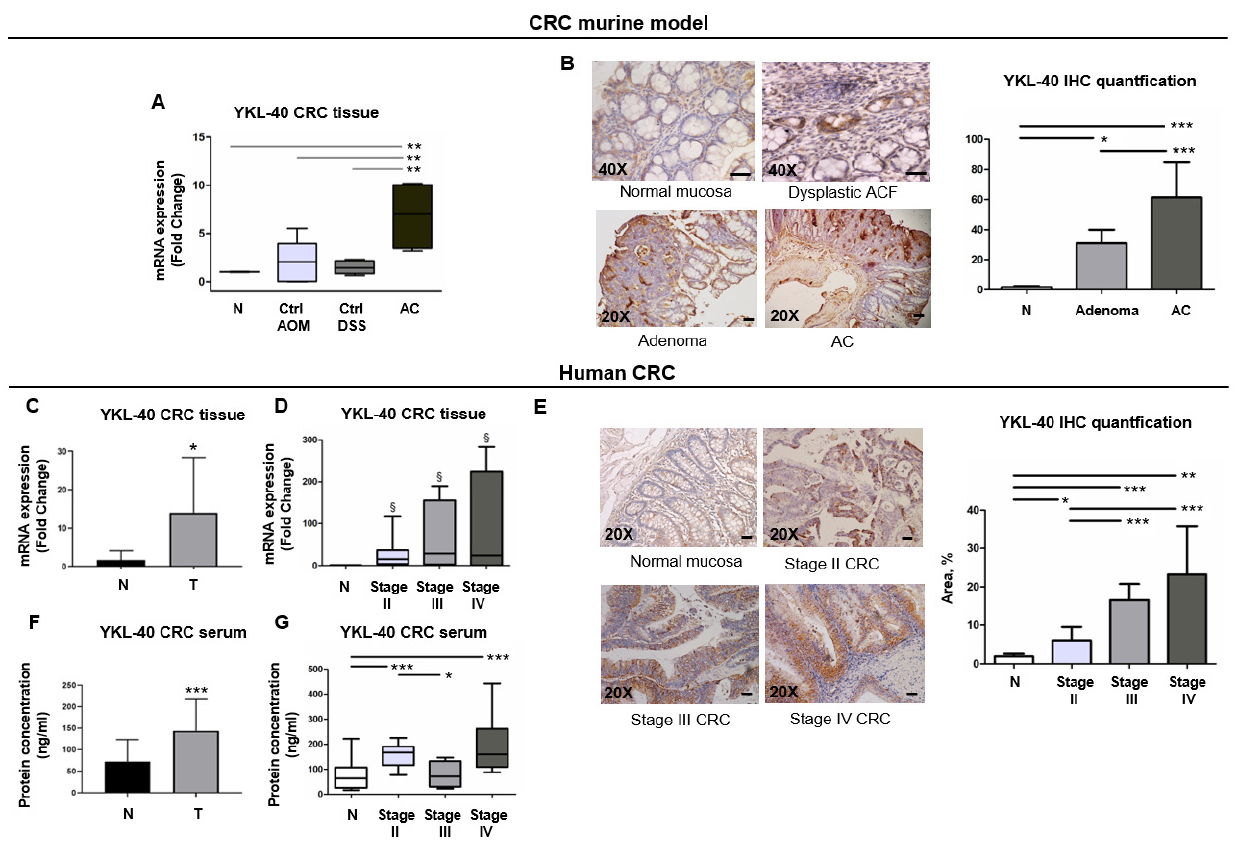
Figure 4. YKL-40 is overexpressed in CRC mouse model and can be used for differentiation of cancerous from normal mucosa. ( A ) qPCR analysis of YKL-40 mRNA levels in murine colon normal mucosa (N) ( n = 5) and only-AOM- (Ctrl AOM) ( n = 5) or only-DSS-treated (Ctrl DSS) ( n = 5) mucosa and adenocarcinoma (AC) ( n = 5). ( B ) IHC analysis of YKL-40 protein in murine dysplastic ACF, adenoma, and adenocarcinoma (AC) and its quantification. ( C ) qPCR analysis of YKL-40 mRNA levels in tumoral and matched non-tumoral tissues of CRC patient samples ( n = 41) and ( D ) in samples stratified for CRC stages. ( E ) IHC analysis of YKL-40 protein in human colorectal tumoral and normal tissues and its quantification. ( F ) Measurement of YKL-40 protein levels both in normal individuals’ ( n = 43) and in CRC patients’ ( n = 43) sera and ( G ) in samples stratified for CRC stages. ( A - G ) Data are shown as mean ± SD. Statistically significant differences were calculated using Student’s t test: *** p < 0.0001; ** p < 0.001; * p < 0.01; § p = 0.1. ( B,E ) 20× and 40× magnification. Scale bars, 50 µm.